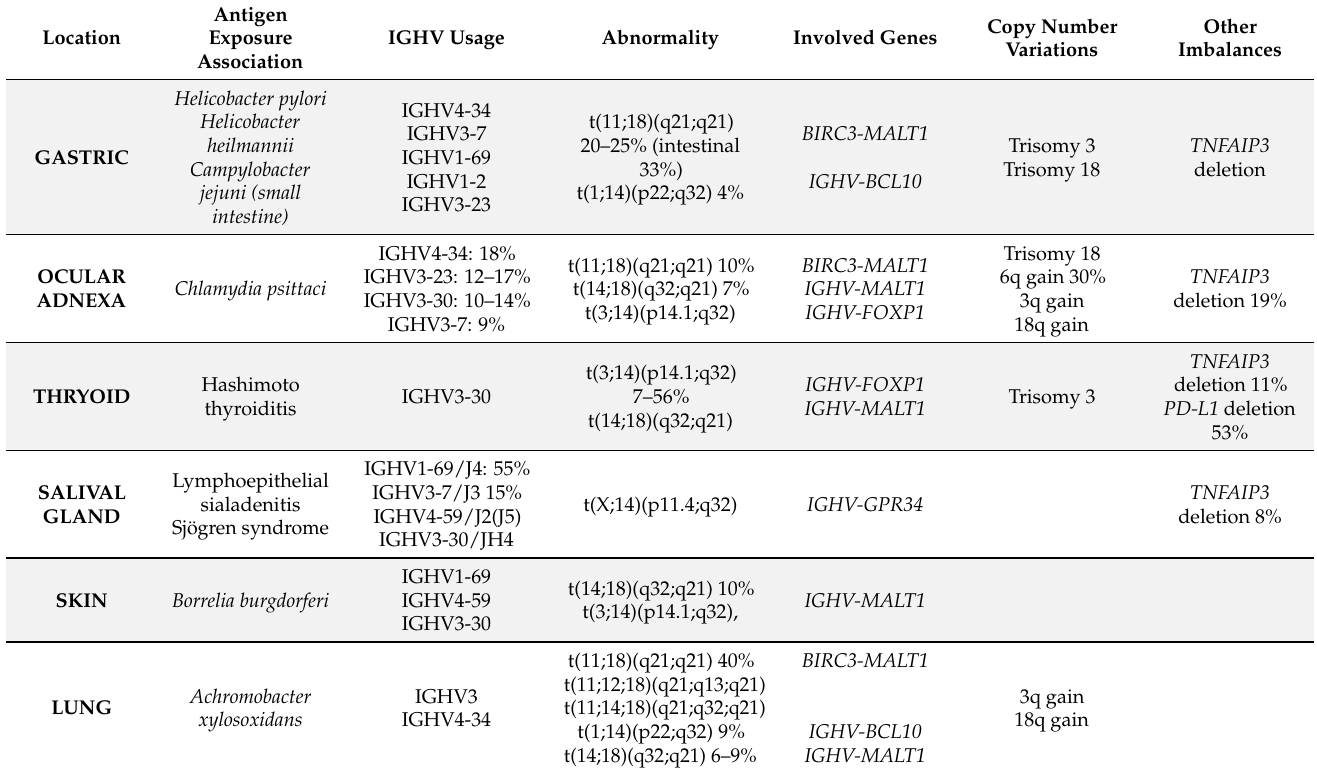
Table 1. Most common genetic aberrations detected in MALT lymphomas at different